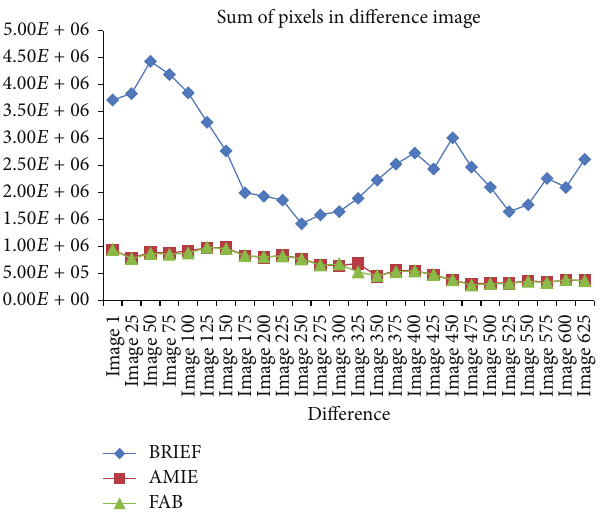
Figure 8: DOI analysis of video frames captured using handheld moving camera (as shown in Figure 7); small values show minimum difference in matched images and hence good matching